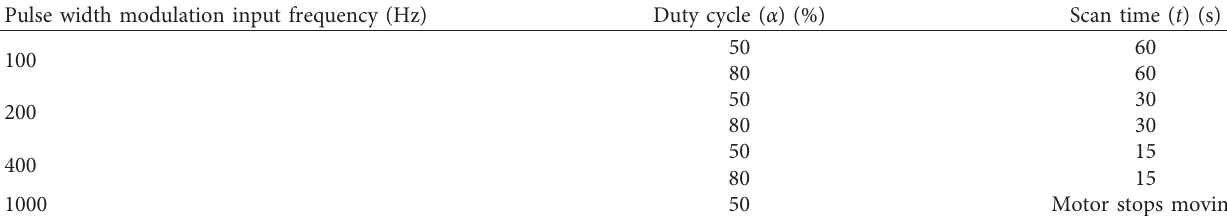
Table 1: Scanning time of azimuth motion in different